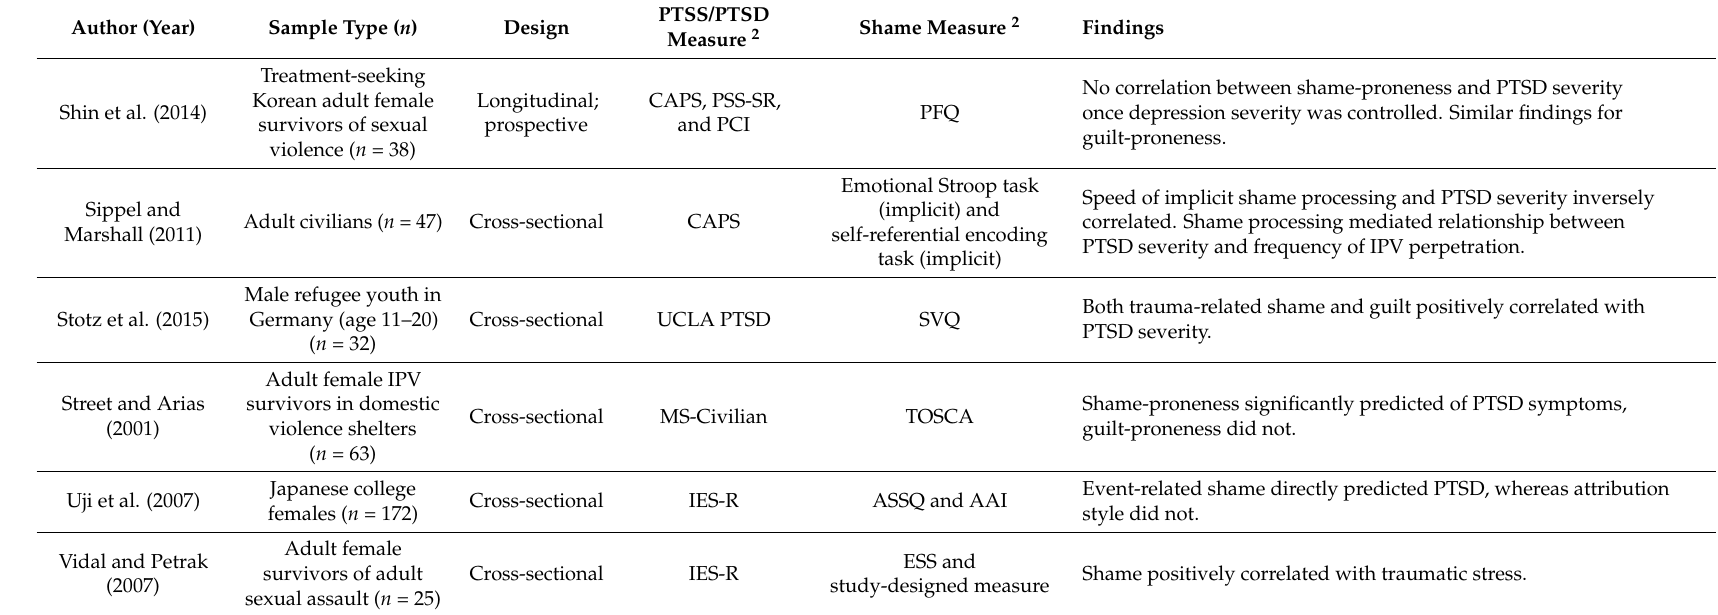
PTSD severity and frequency of IPV